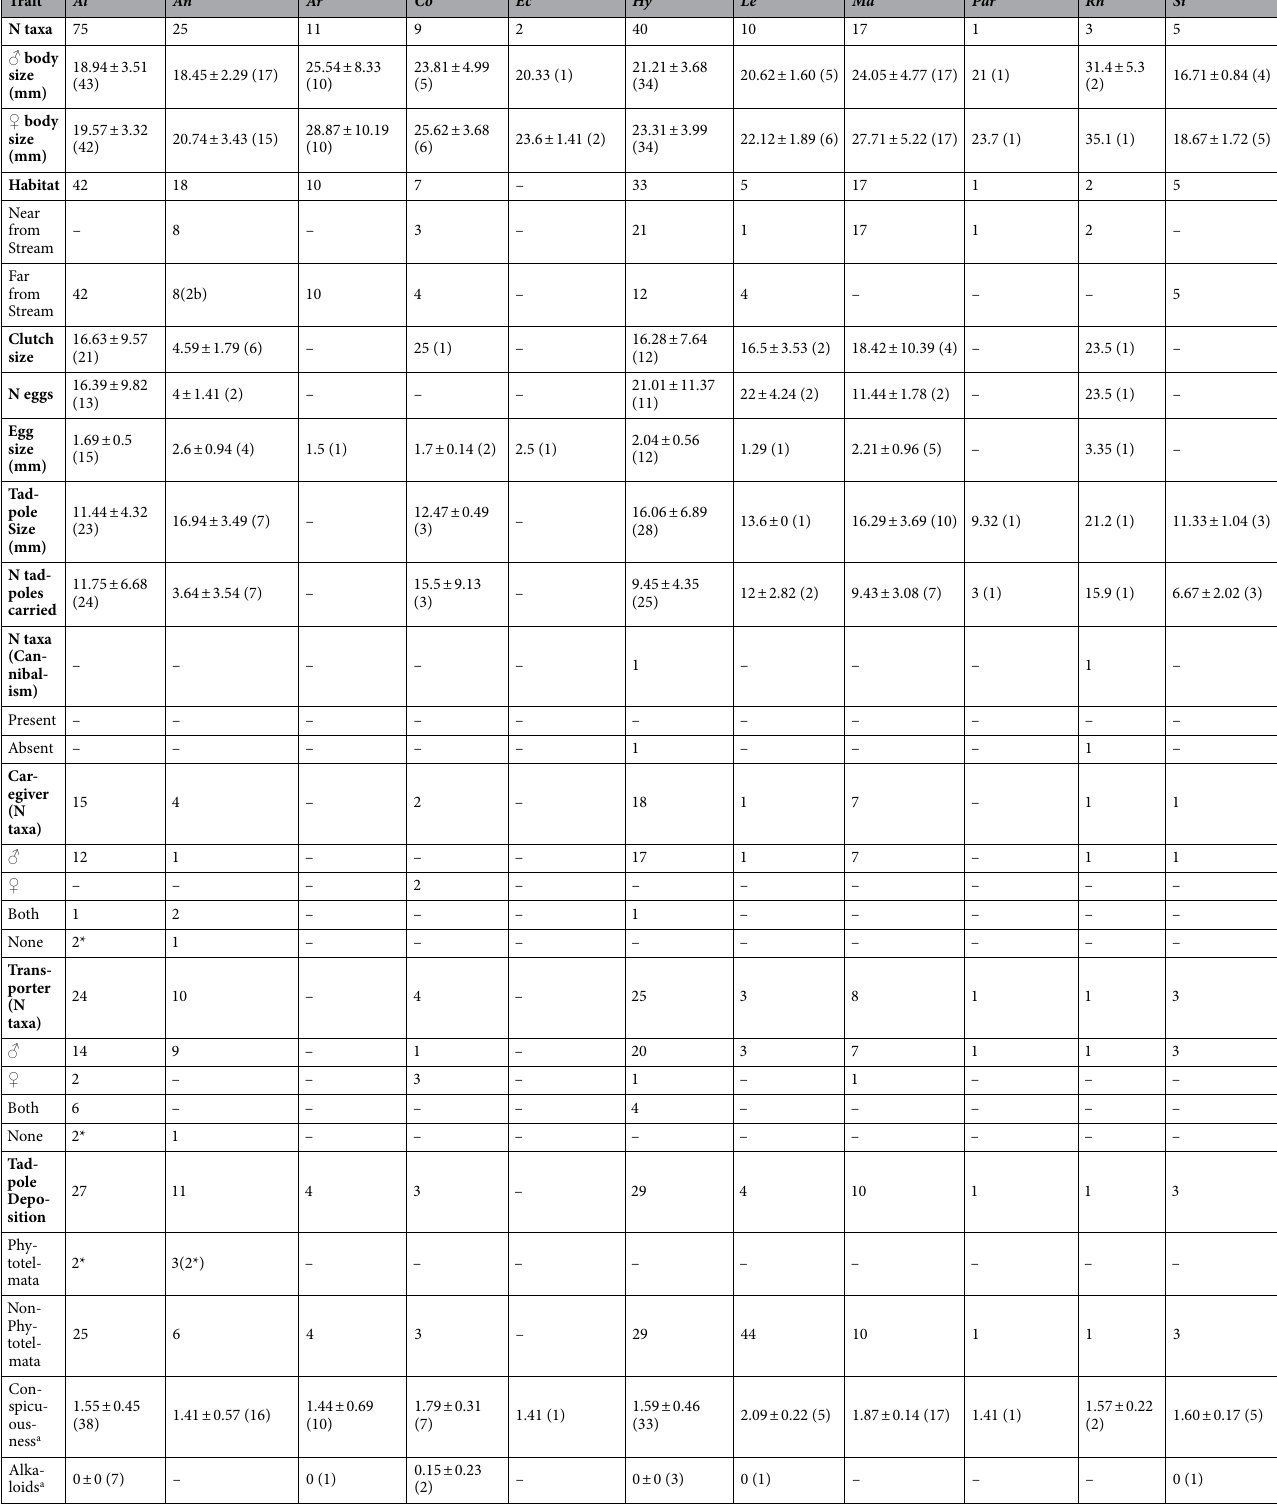
Table 2. Parental care traits in dendrobatid species considered to be non-aposematic. The symbol “–“ corresponds to unknown data. a Conspicuousness and alkaloids scores are described in the methods section; *These species are nidicolous. Vales are reported as mean ± SD (number of